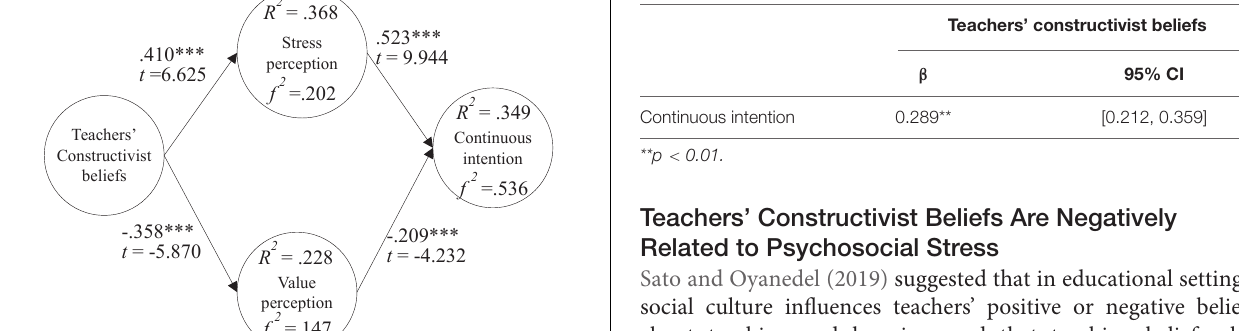
TABLE 4 | Indirect effect